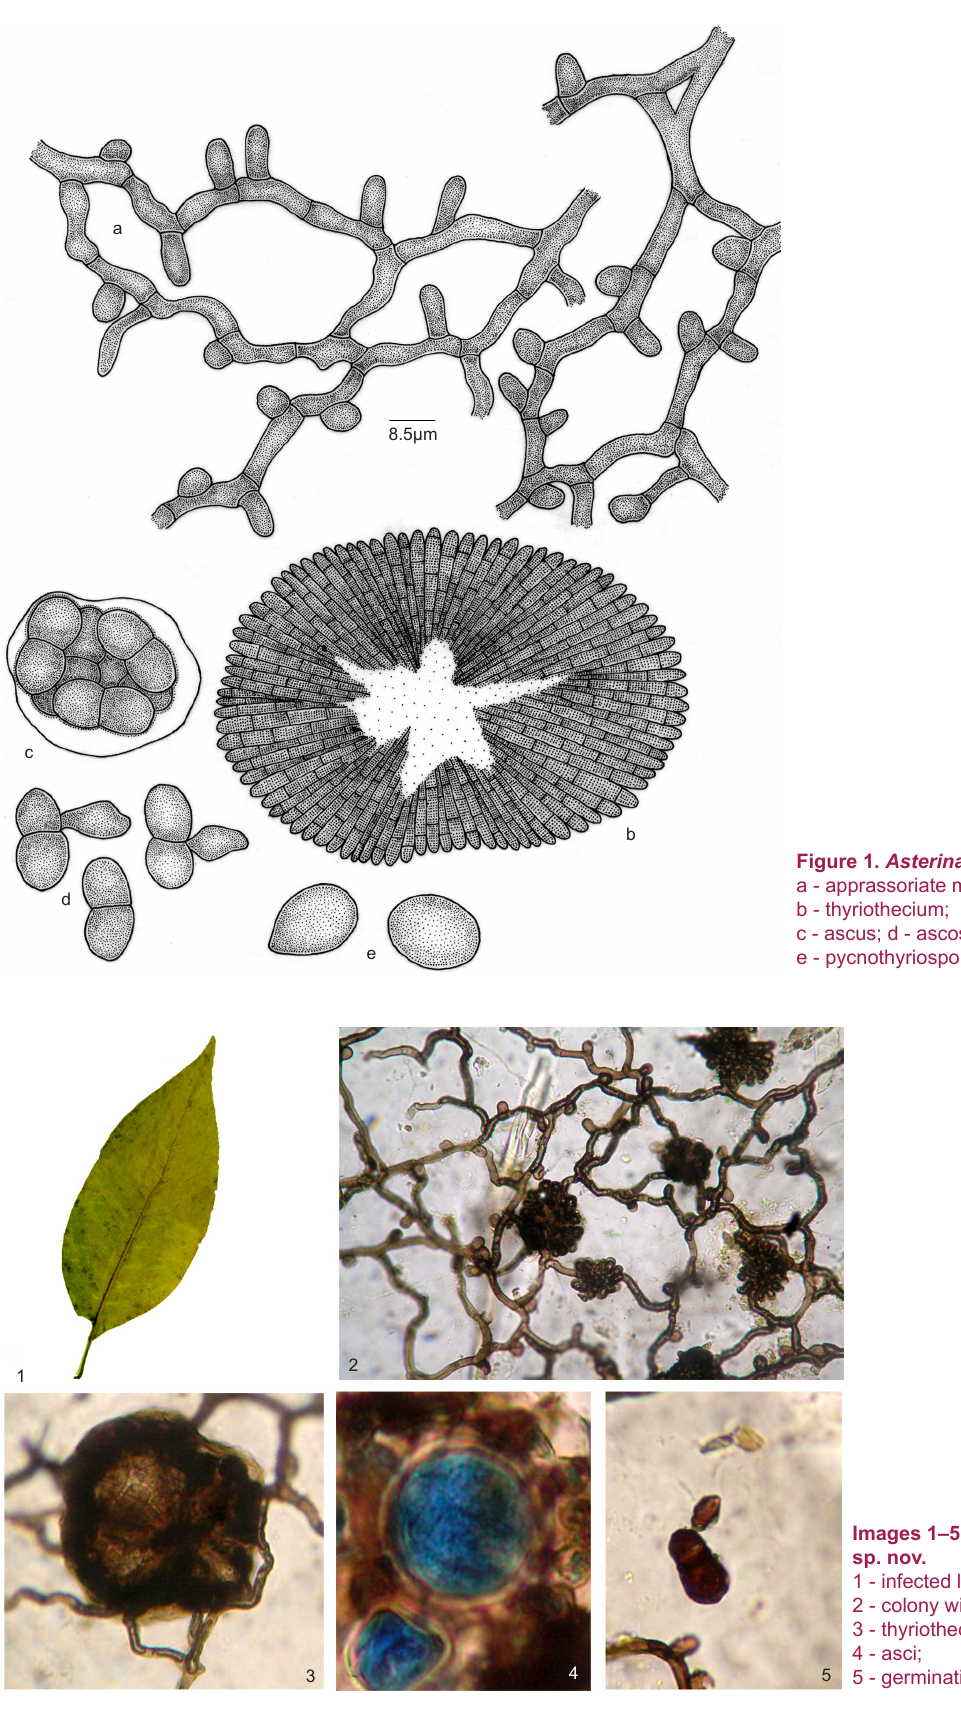
Images 1–5. Asterina michelifolia sp. nov.